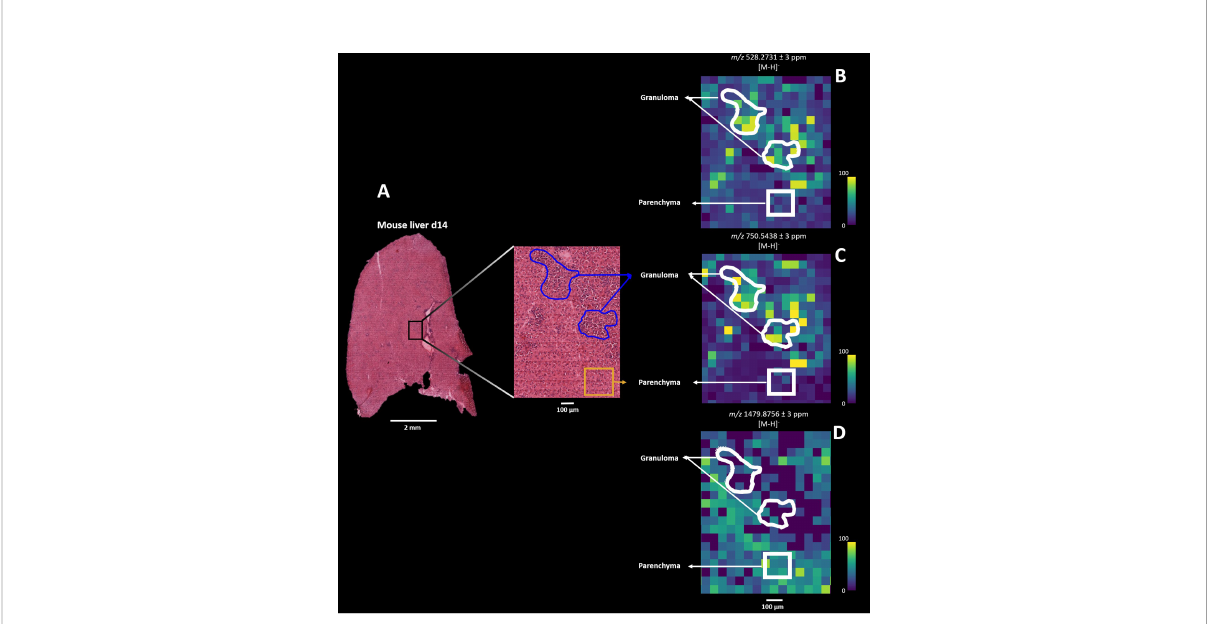
FIGURE 5 Pathology-guided mass spectrometry imaging work fl ow. Figure shows the ability to deduce analyzed lipid features from morphologic regions of interest (ROI): (A) Zoomed-in histopathological characterization of granulomas (blue) and surrounding parenchyma (yellow) in L. donovani - infected mice liver (d14 p.i.). H&E-stained images are co-registered with mass spectrometry images for subsequent spatial lipid analysis from annotated granuloma and parenchymal ROIs. (B) Spatial distribution of m/z 528.2731 ± 3 ppm, (C) m/z 750.5438 ± 3 ppm and (D) 1479.8756 ± 3 ppm from the granuloma and parenchymal